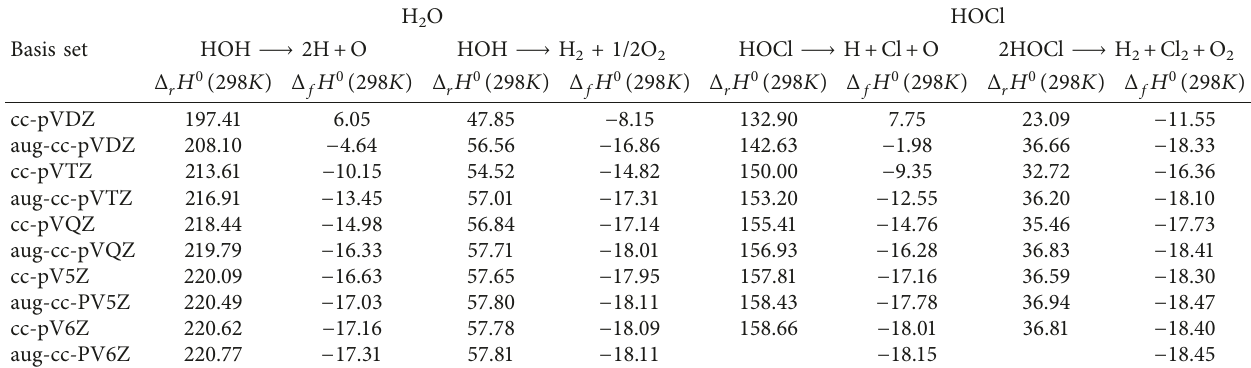
Figure 6: Average values and maxima and minima of the enthalpy of formation of HOCl obtained from the five reactions considered (in red) or only from reactions (3) and (4) (in blue). Table 5: Enthalpies of reaction and derived standard enthalpies of formation (in kcal/mol) for water and hypochlorous acid using different